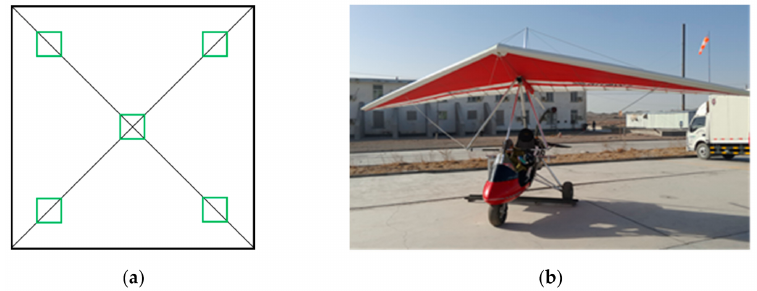
Figure 3. Sampling methods and hyperspectral image acquisition method: ( a ) schematic diagram of sampling quadrat; ( b ) aerial detection platform.